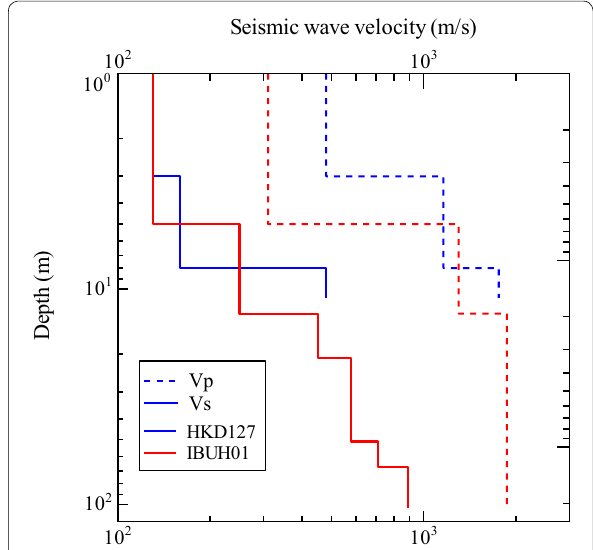
Fig. 11 P- and S-wave velocity profiles based on PS-loggings at sites IBUH01 (red lines) and HKD127 (blue lines). The P- and S-wave velocity profiles are drawn in dashed and solid lines, respectively. The vertical axis is drawn in log-scale to show the shallow layers clearly. The scale begins from 1 and corresponds to the free surface at the recording